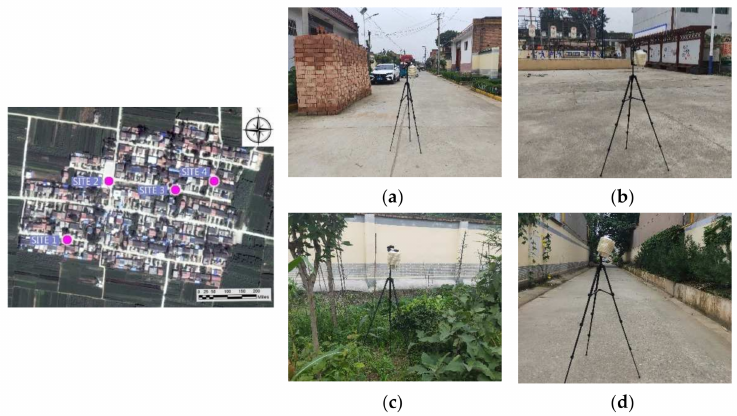
Figure 2. The locations of the measuring sites: ( a ) site 1, ( b ) site 2, ( c ) site 3, and ( d ) site 4.